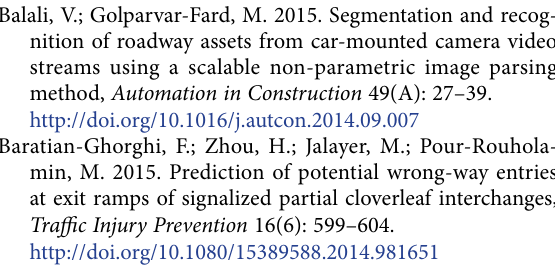
Fig. 8. Vandalized signs by mount height vs. (a) exposure and (b) road type